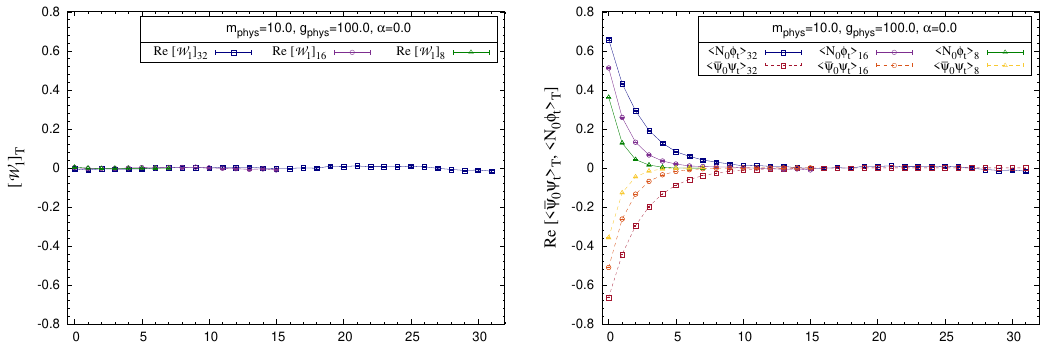
Figure 4 . Real part of the Ward identity (left) and real part of the bosonic and fermionic con- tributions to the Ward identity (right), versus lattice site t for lattices with T . Simulations were performed for SUSY anharmonic oscillator with physical parameters m phys = 10 and g phys = 100 for lattice sizes T = 8 , 16 , and 32 .